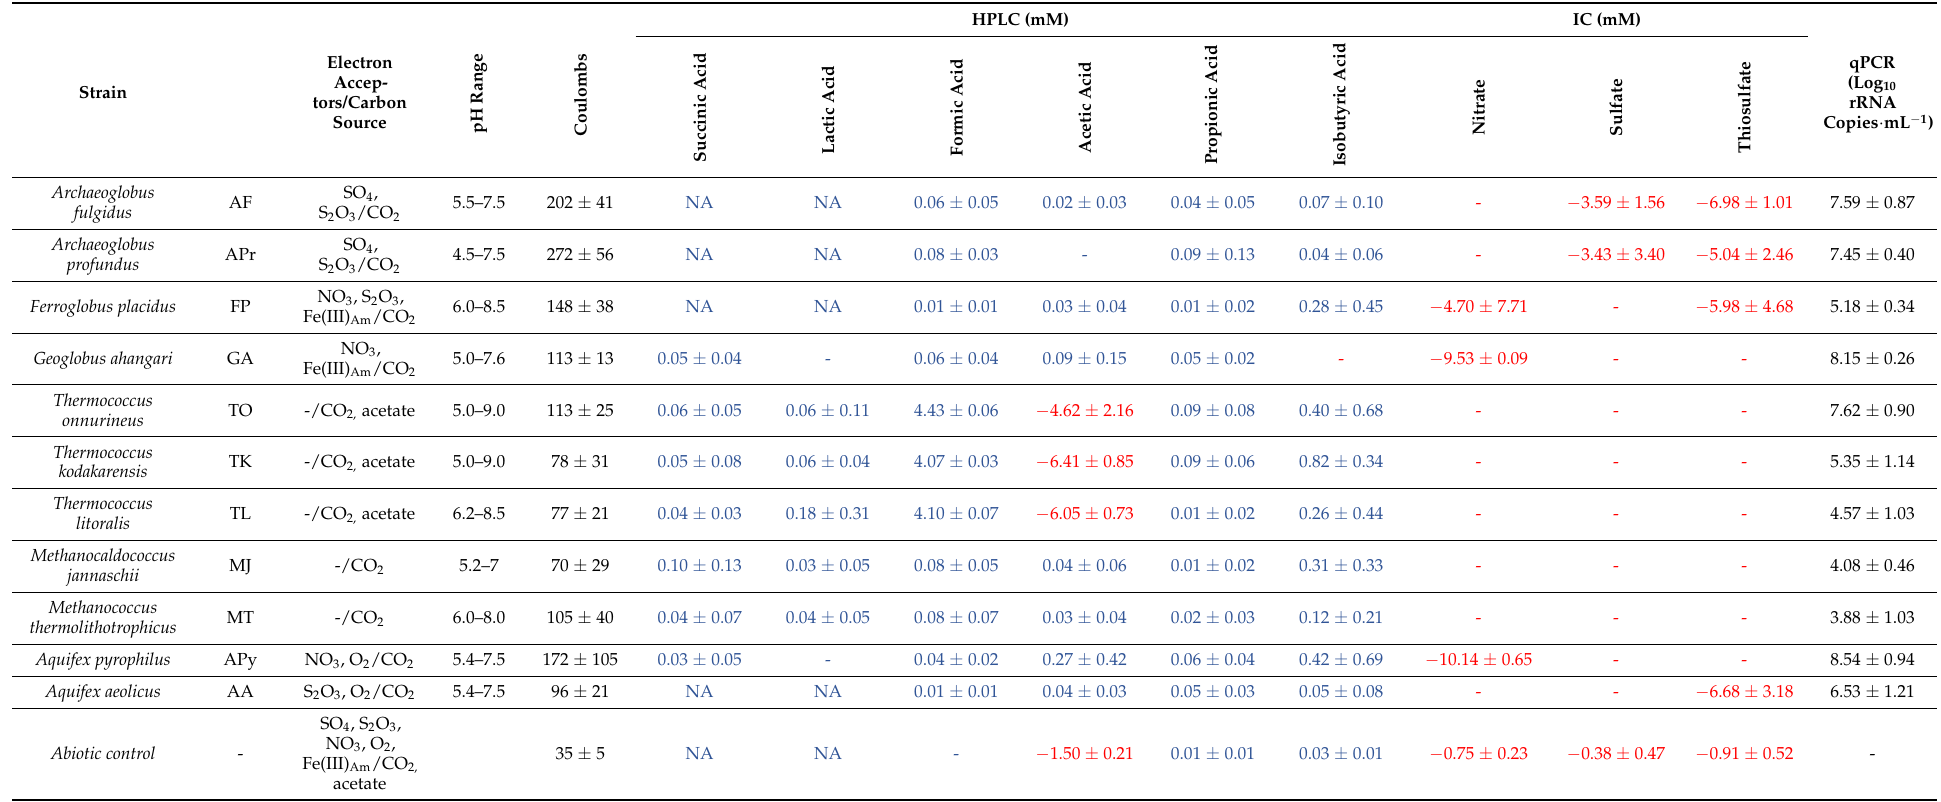
Table 1. Summary of the screening experiment on the 11 (hyper)thermophilic strains. The soluble electron acceptor or carbon source was provided at 10 mM. The total charge consumption (in coulombs), the organic production, measured by HPLC, the electron acceptor consumption, measured by IC, and the cell density on the electrode, measure by qPCR, are presented here. NA: non available, the succinic and lactic acids could not be measure when thiosulfate was used as electron acceptor due to overlapping retention time with the HPLC method. Blue-colored values represent production, while red-colored values represent consumption. pH ranges were obtained from literature